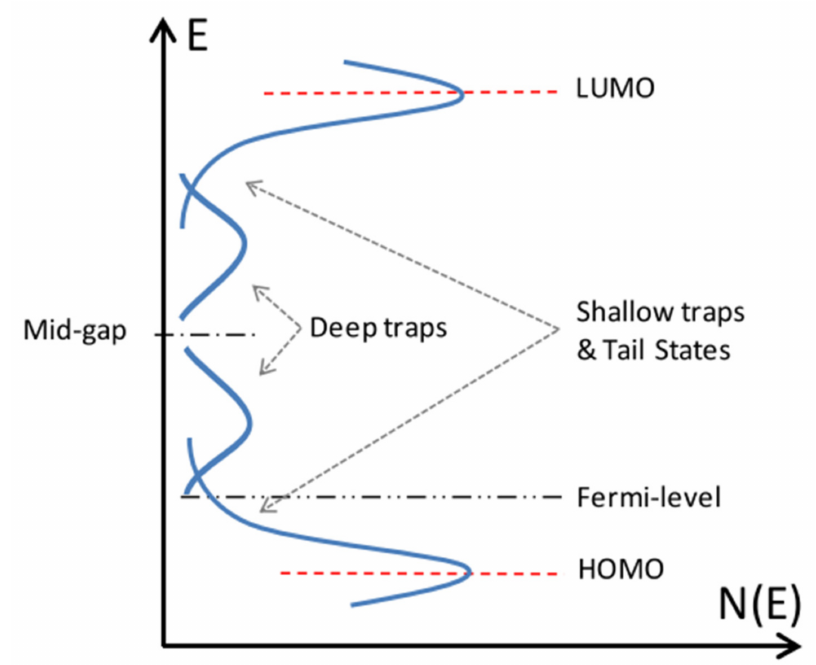
Figure 7. A presentation of the trap states between HOMO and LUMO. Reprinted with permission from ref. [83]. Copyright 2013 Royal Society of